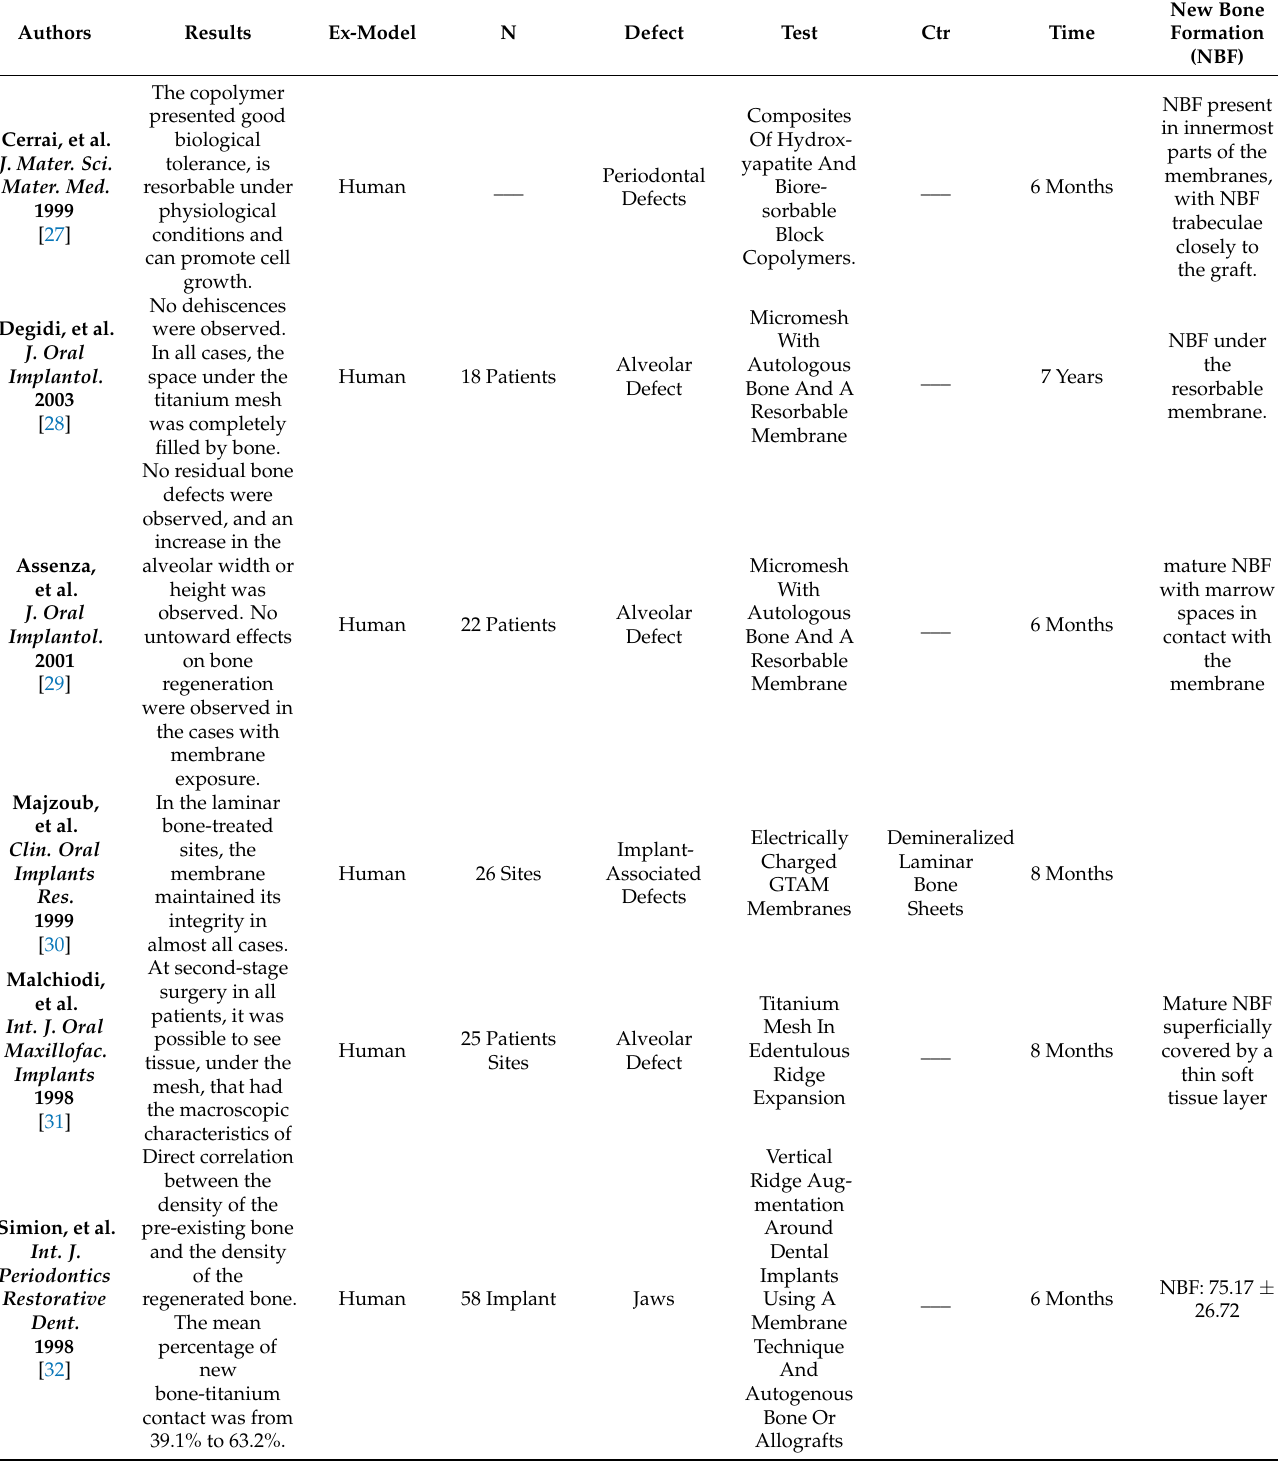
Table 3. Summary of the human studies